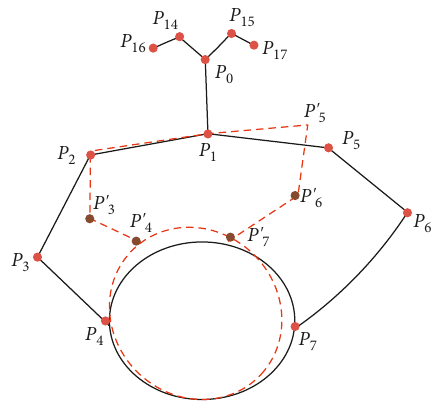
Figure 3: The driver’s arm posture movement.